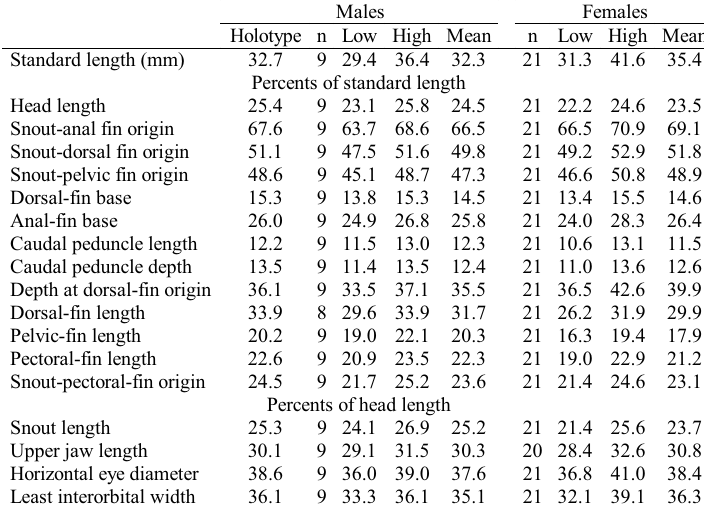
Table 2. Morphometrics of Odontostilbe splendida (holotype ANSP 181040, and paratypes ANSP 181041). Males Females Holotype n Low High